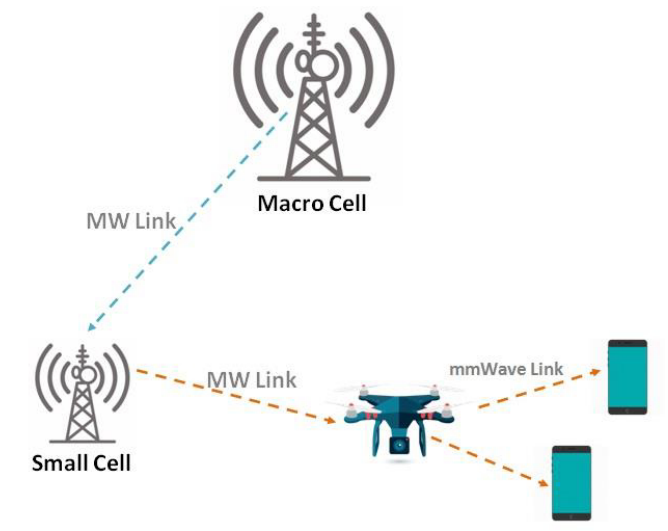
Fig 11. UAV Assisted Macro to Small Cell to UAV to UE